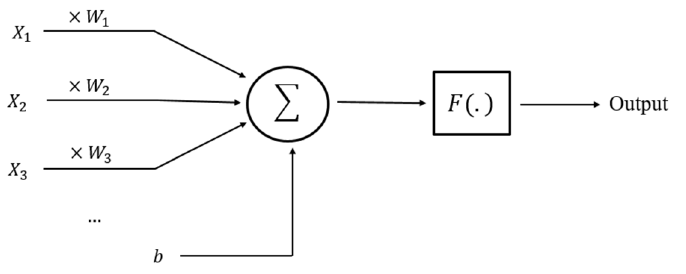
Figure 3. Schematic diagram of a multilayer perceptron neural network (MLP-NN) neuron.